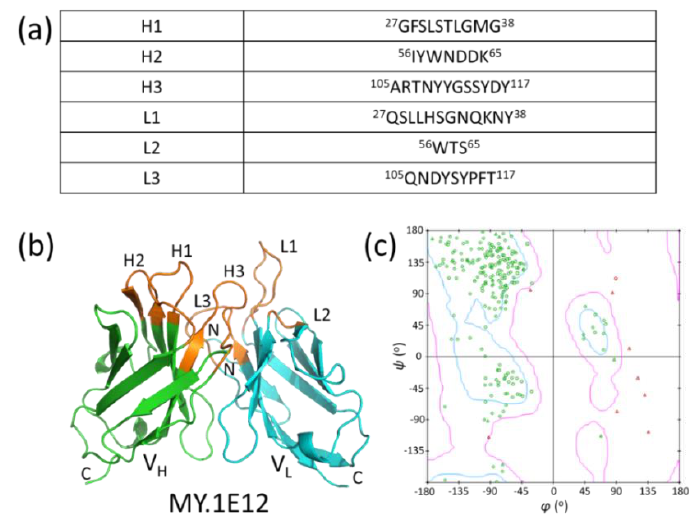
Figure 6. Construction of a 3D model of MY.1E12 Fv region. ( a ) Amino acid sequences of MY.1E12 CDRs defined by IMGT. ( b ) A 3D model of MY.1E12 Fv fragment generated by homology modeling. V H : variable region of H chain, V L : variable region of L chain. Orange: CDR. ( c ) Ramachandran plot of the modeled MY.1E12 Fv region. Gly is shown as triangles, Pro squares, and the other amino acid residues as circles. Green symbols are within the energetically favorable region (boundary line in pink) and red symbols are located outside the region.